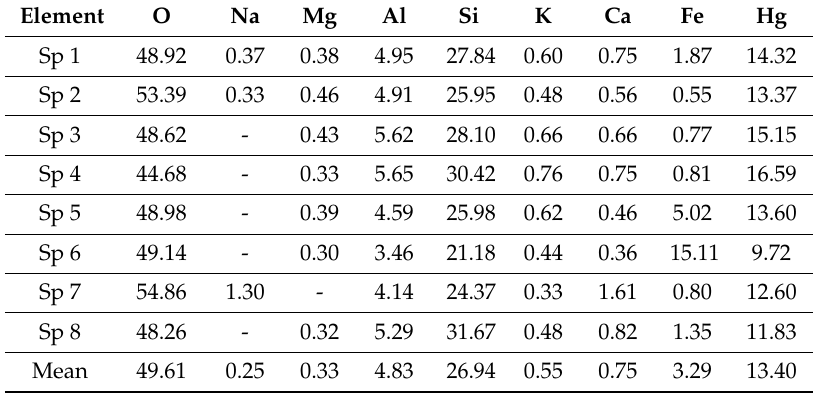
Table 3. Mass percentage values of the detected elements on the eight marked surfaces (Spectra, Sp) for FeZHg.